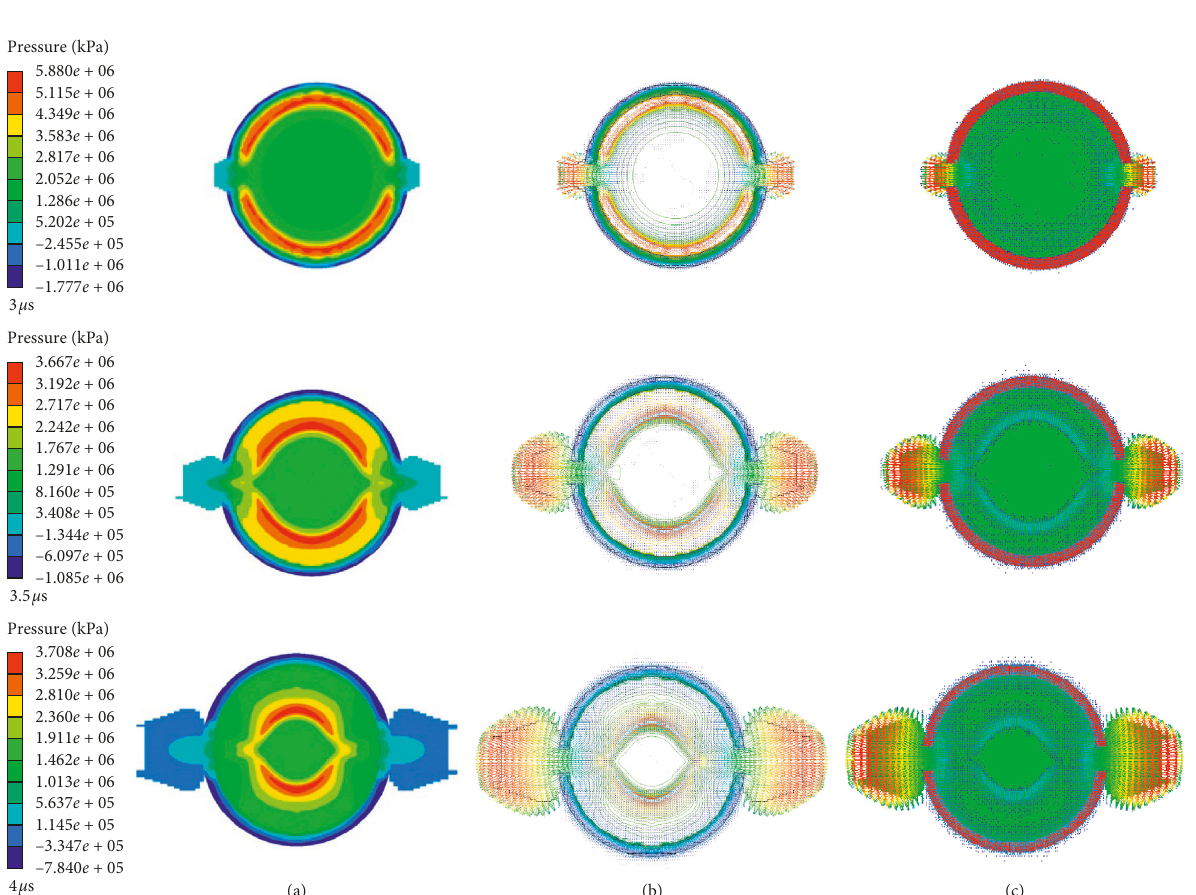
Figure 12: Blast wave propagation of cutting seam cartridge in free field. (a) Effective stress. (b) Pressure line. (c) Velocity vector.